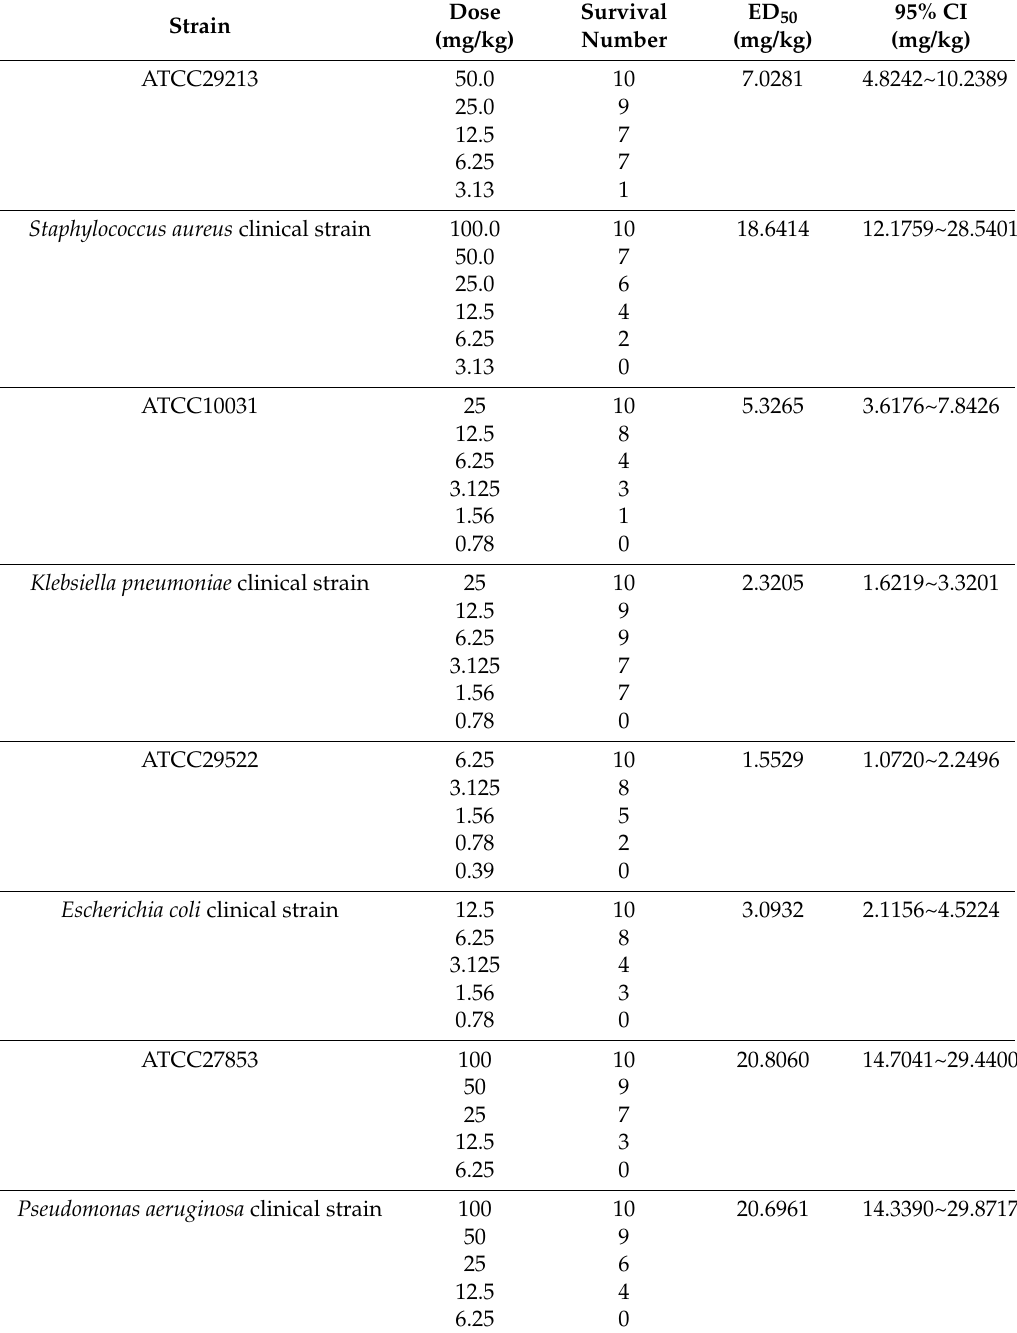
Table 6. ED 50s of tebipenem pivoxil in various sepsis models.